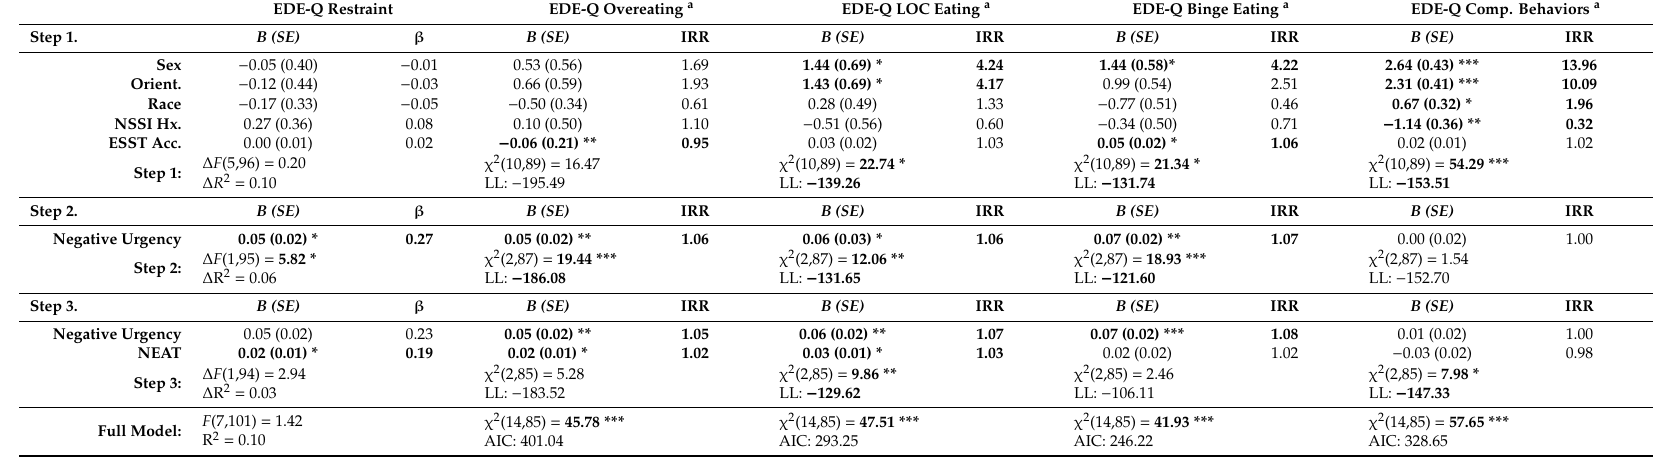
Table 4. Hierarchical regression analyses: Behavioral ED symptoms ( N =